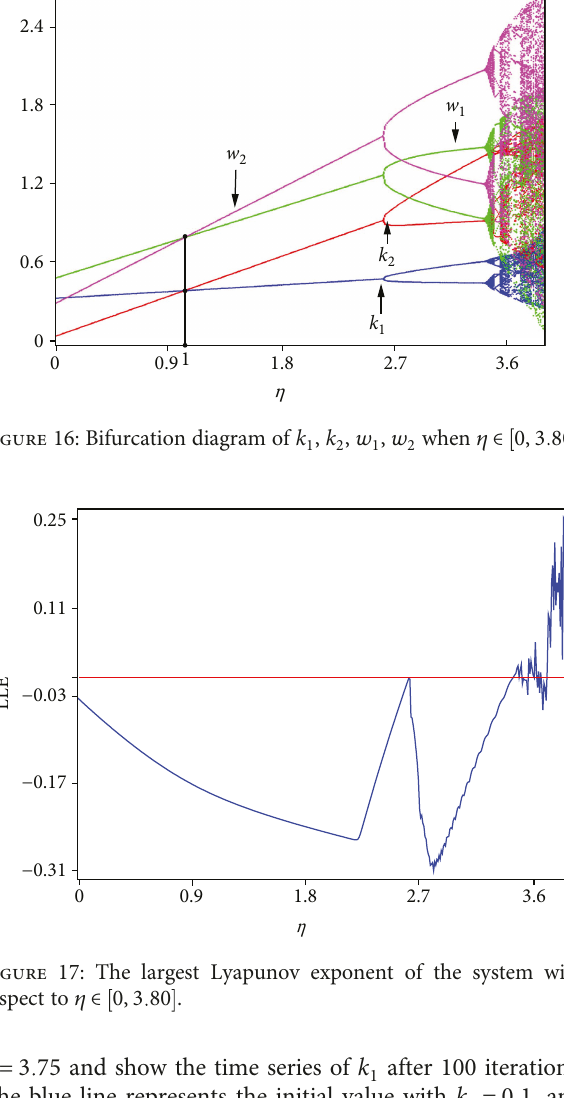
respect to μ ∈ 0 8, 0 89 .